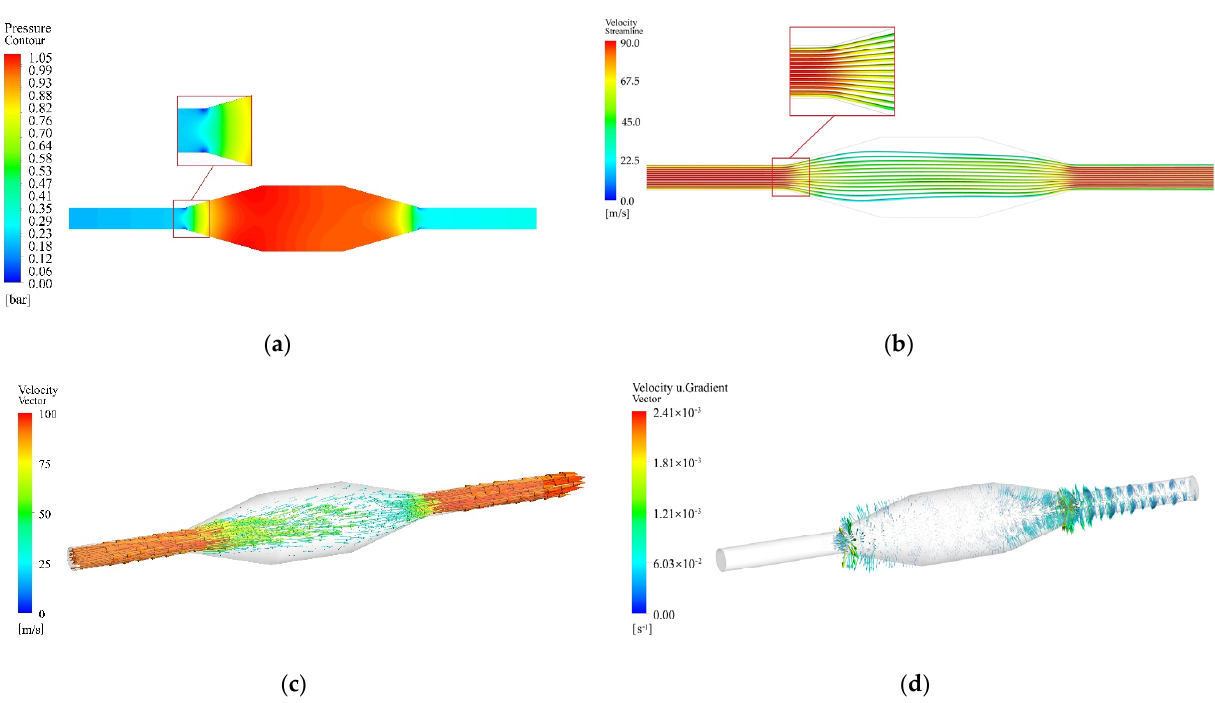
Figure 9. Flow characteristics results of the 1D–3D approach numerical analysis for the tapered pipe shape (expansion duct of SCR): ( a ) pressure contour; ( b ) streamline; ( c ) velocity vector; and ( d ) velocity u gradient.